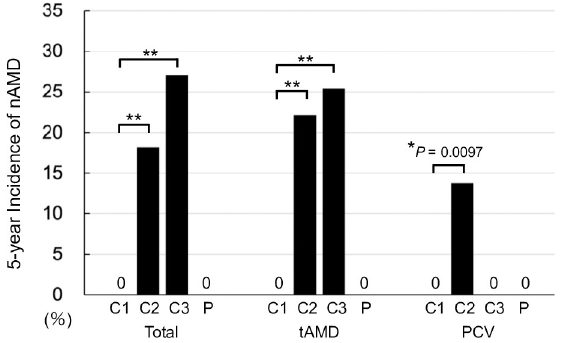
Fig 3. Five-year incidence of nAMD in each category according to the first eye’s AMD subtypes. �� P < 0.0001. � P < 0.01. Fisher’s exact test.